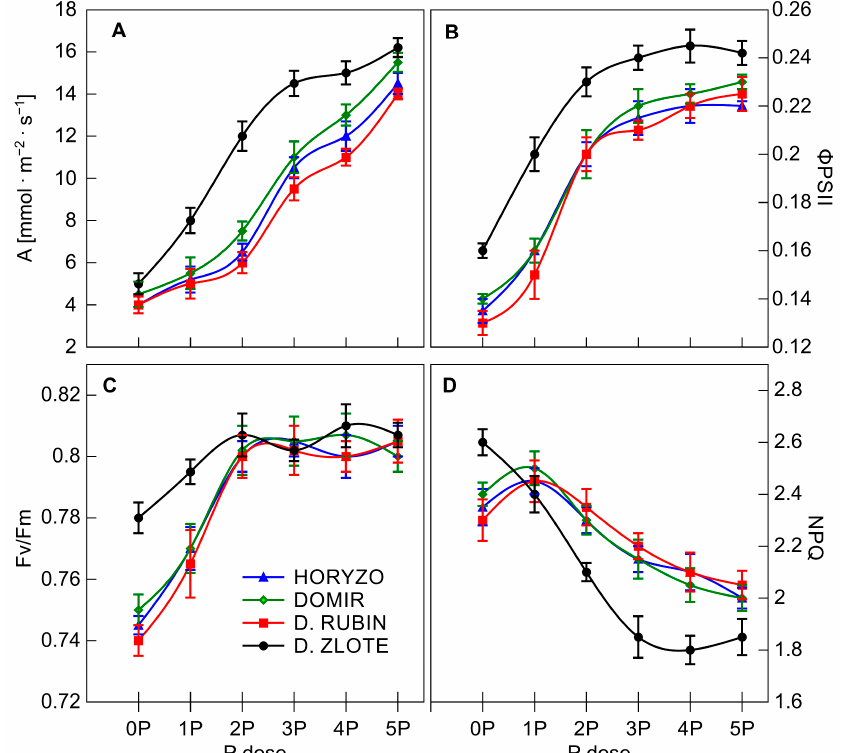
Figure 6. Photosynthetic parameters in rye varieties grown on the post-flotation sediment under variable P supplementation. The intact leaves of dark-adapted plants were illuminated with a 1.2 s followed by the switch on of actinic light (PPFD 850 µ mol · m 2 · s − 1 ) for 30 min to reach a steady state. The CO 2 assimilation rate, A ( A ), photochemical efficiency, Φ PSII ( B ), maximum quantum efficiency, Fv/Fm ( C ), and nonphotochemical quenching, NPQ ( D ) were determined. Data represent the means of n = 9 replications, and vertical bars represent 95% confidence interval after a post hoc Tukey HSD test (interaction P dose × variety), with the letters denoting homogeneous groups being omitted for a clear